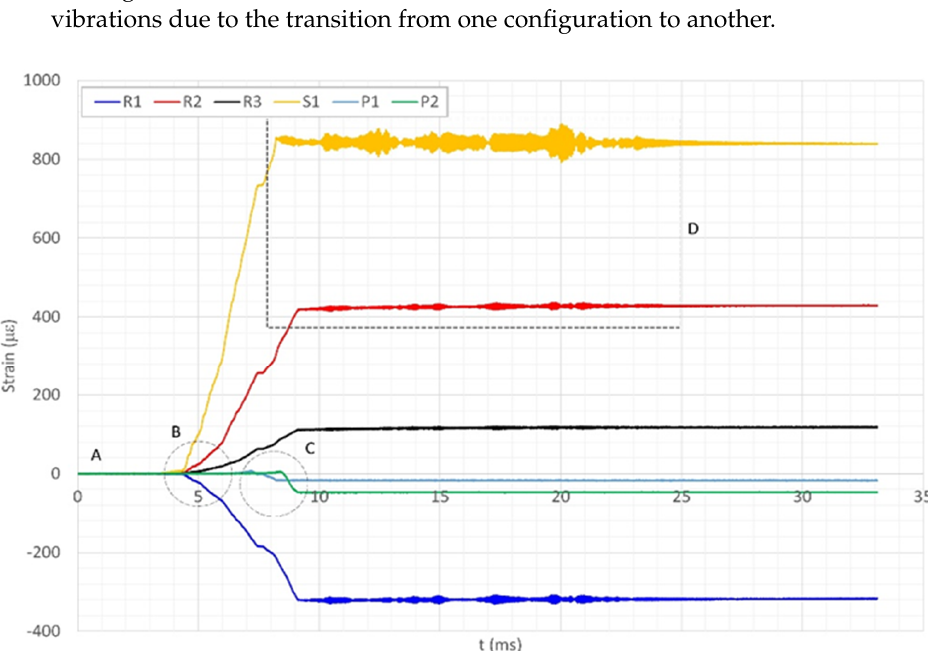
Figure 4. Lifting phase: Strain measurements of all the FBGs vs. time. A, B C and D refer to different time phases.